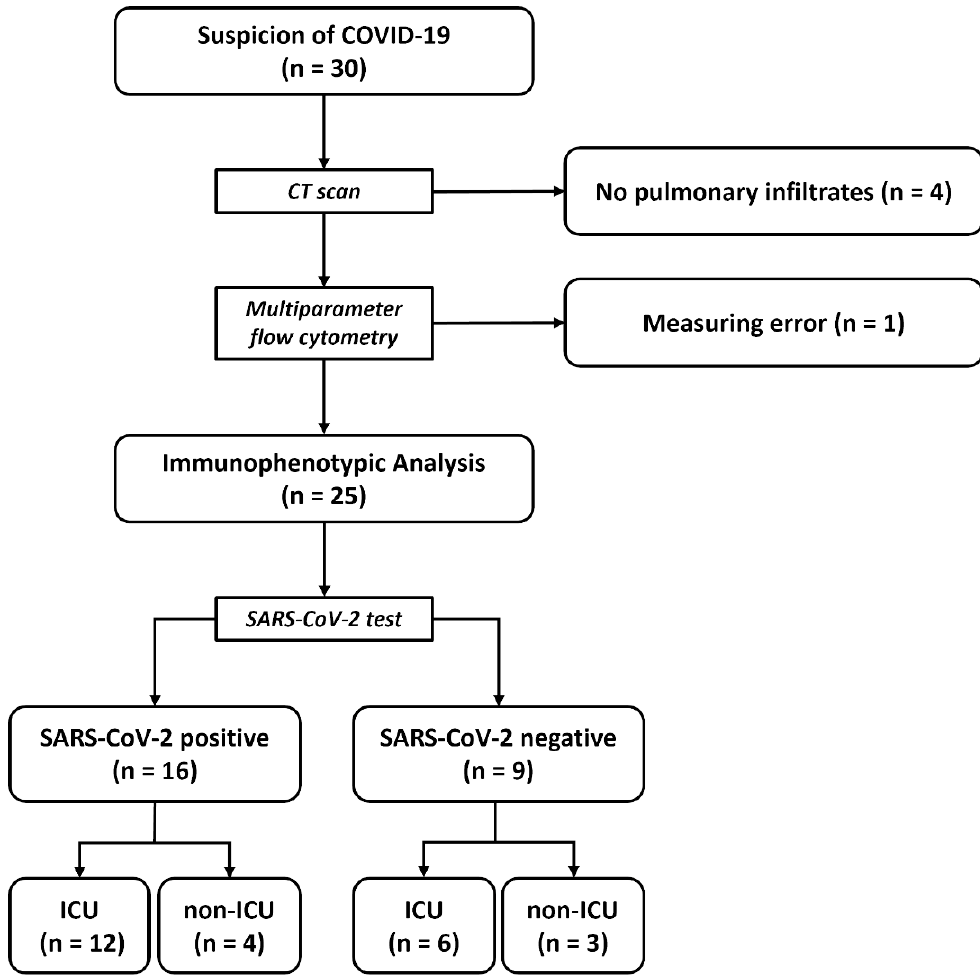
Figure 1. Study population and workflow. Abbreviations: n = number; ICU = intensive care unit, SARS-CoV-2 = severe acute respiratory syndrome coronavirus 2.